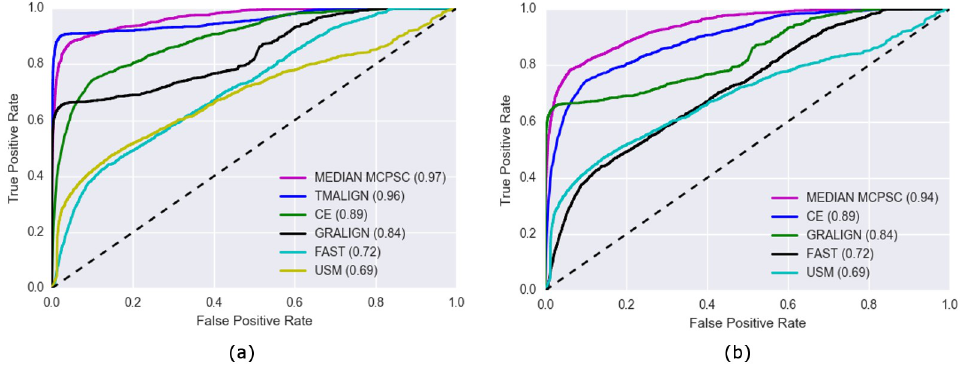
Fig 3. ROC curves of all PSC methods and the median MCPSC method using the Imputed dataset of pairwise similarity scores. The ROCs are generated at the SCOP Superfamily level (Level 3). Panel (a) shows the results with all five PSC methods and panel (b) with TM-align